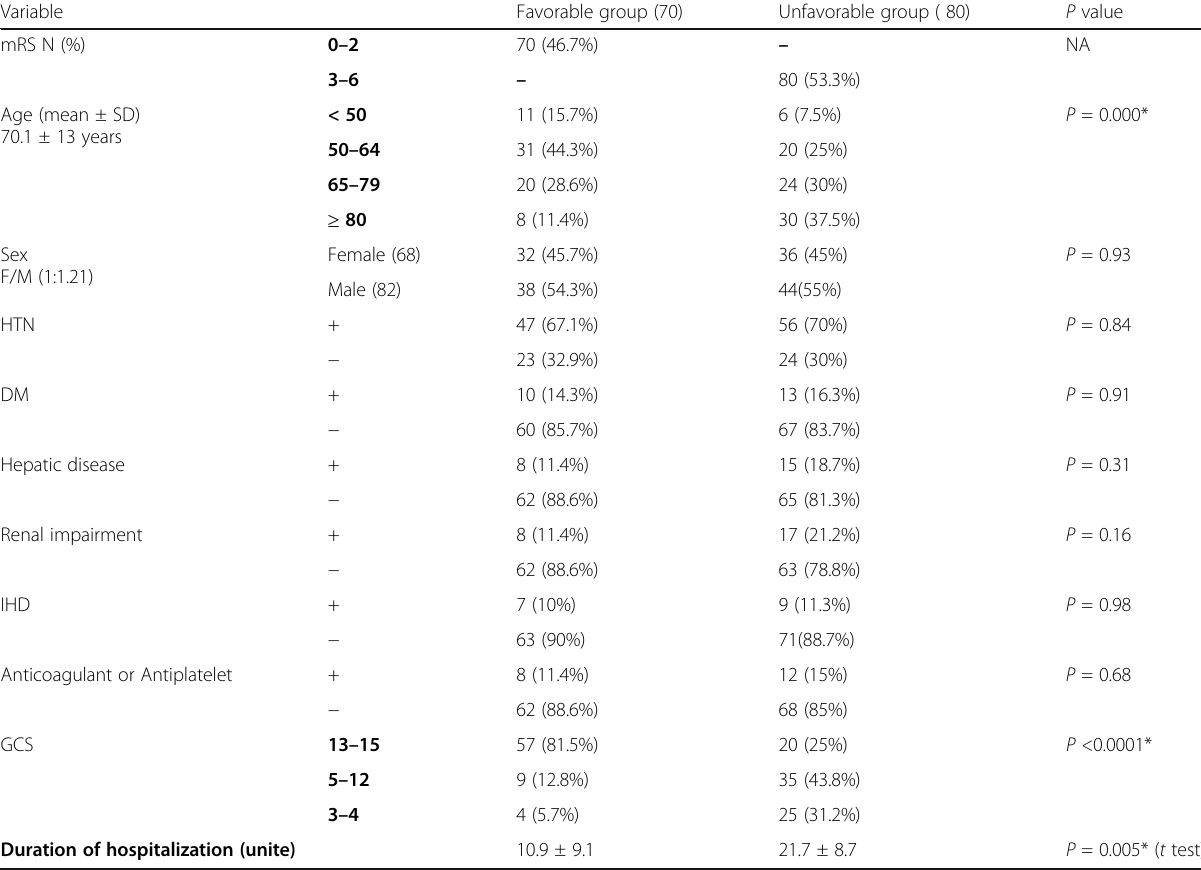
Table 1 Demographic data and risk factors of ICH patients